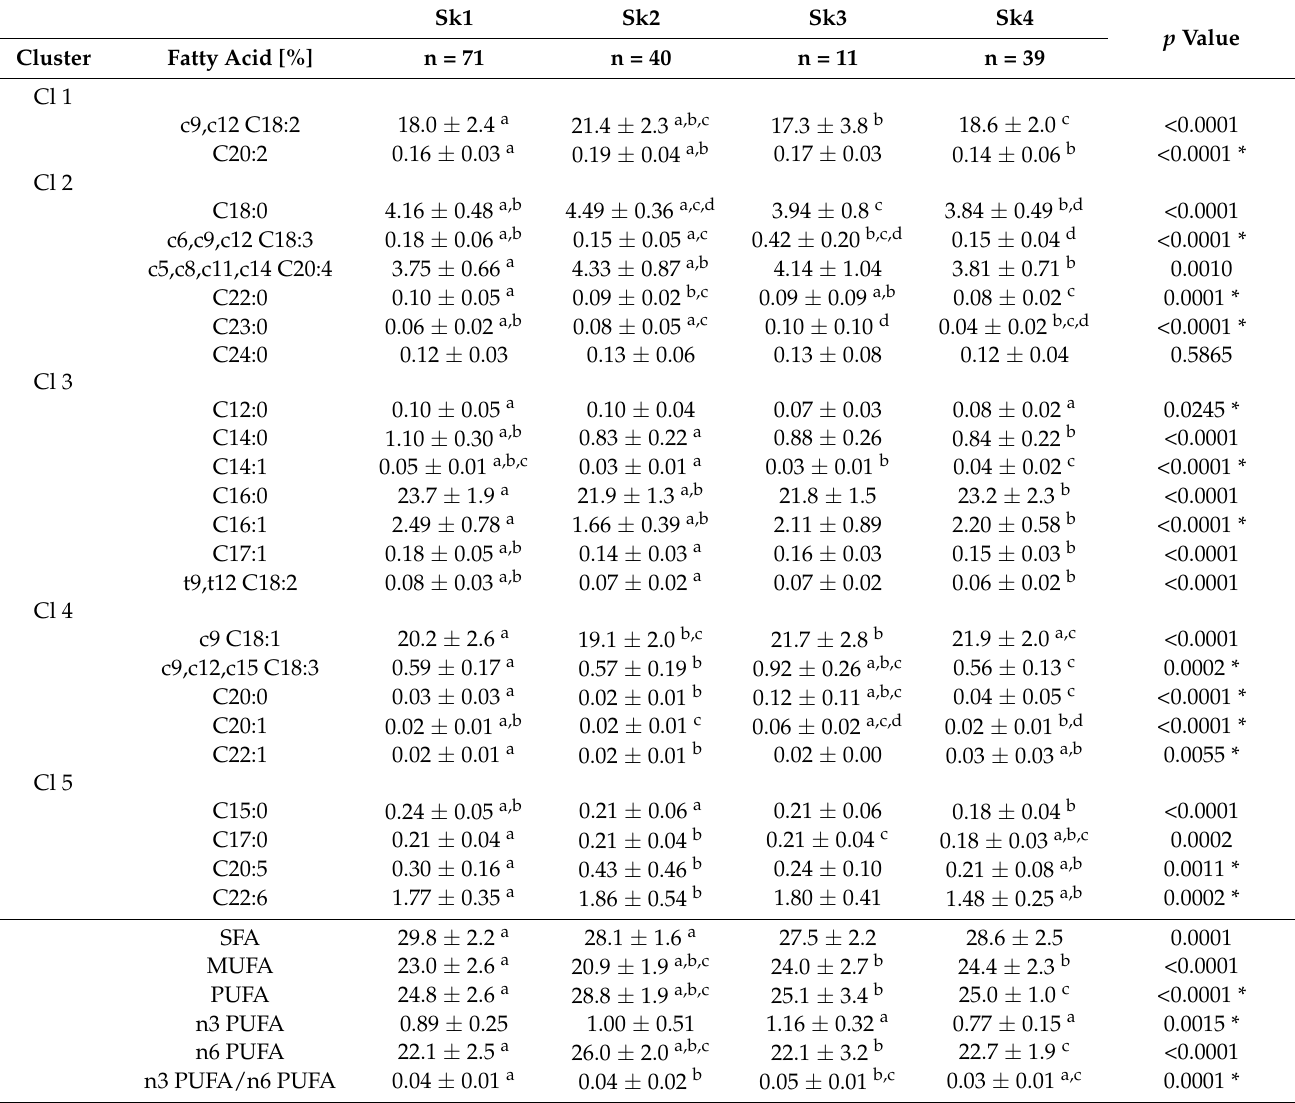
Table 1. Fatty acids profile of serum samples of pregnant